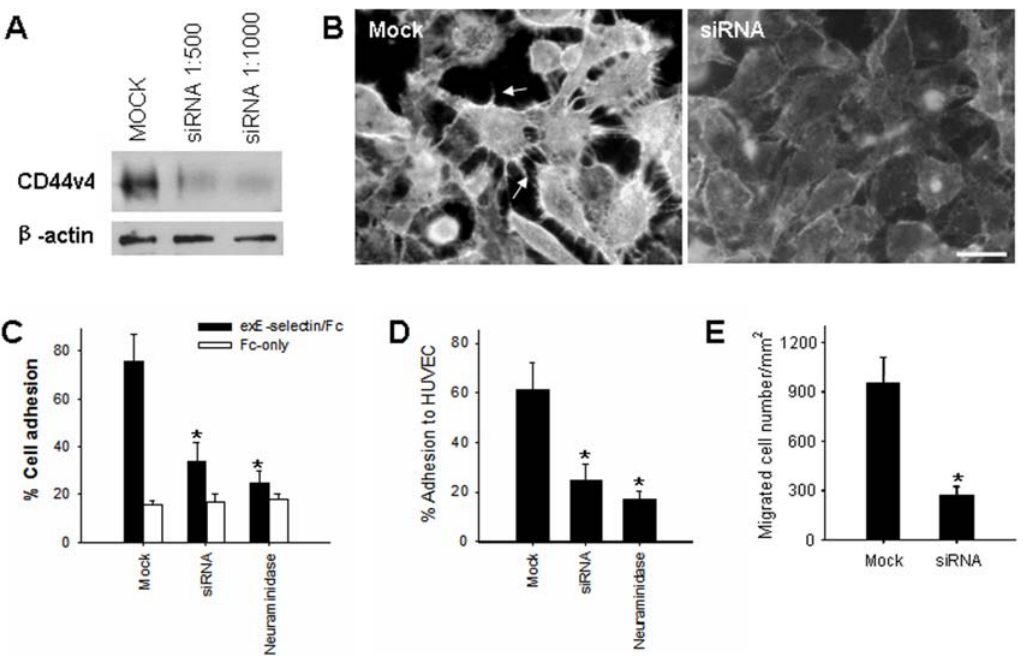
Figure 6. The role of CD44v4 in mediating breast cancer cell adhesion and transmigration. A and B: siRNA transfection-induced CD44v4 downregulation in MDA-MB-231 cells as shown by Western blot (A) and immunofluorescence labeling (B), respectively. C and D: reduction of MDA- MB-231 cell adhesion to immobilized recombinant exE-selectin/Fc (C) and TNF- a pre-activated HUVEC monolayers (D) after CD44v4 downregulation via siRNA. E: reduction of MDA-MB-231 cell transendothelial migration by CD44v4 downregulation. The data are representative of three independent experiments.